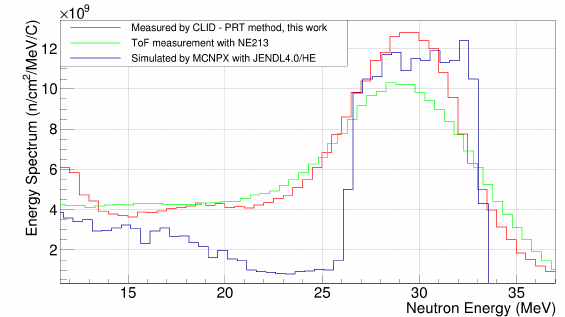
Figure 8. Spectral neutron fluxes measured by PRT method and normalized by 88 Y production rates (red), measured by the NE213 (green) and simulated by the MCNPX code using the JENDL4.0/HE data library (blue)[24, 25].